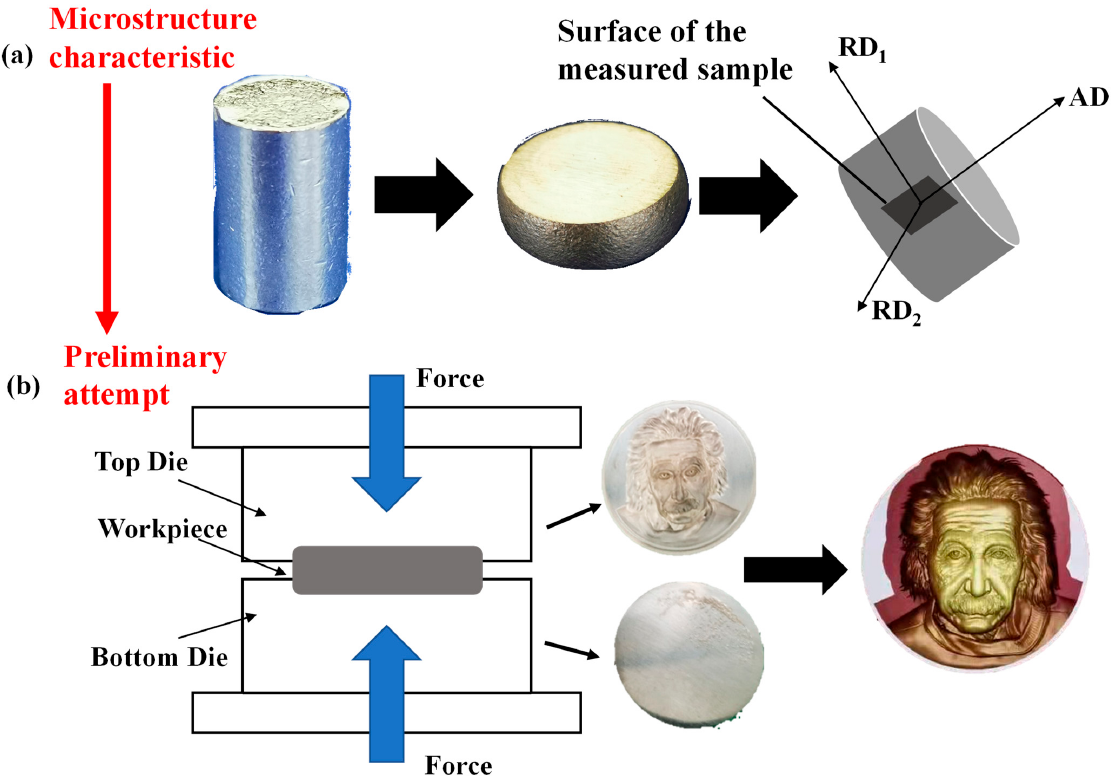
Figure 1. Schematic of experiments for ( a ) isothermal compression tests and ( b ) the closed multi- coining process.